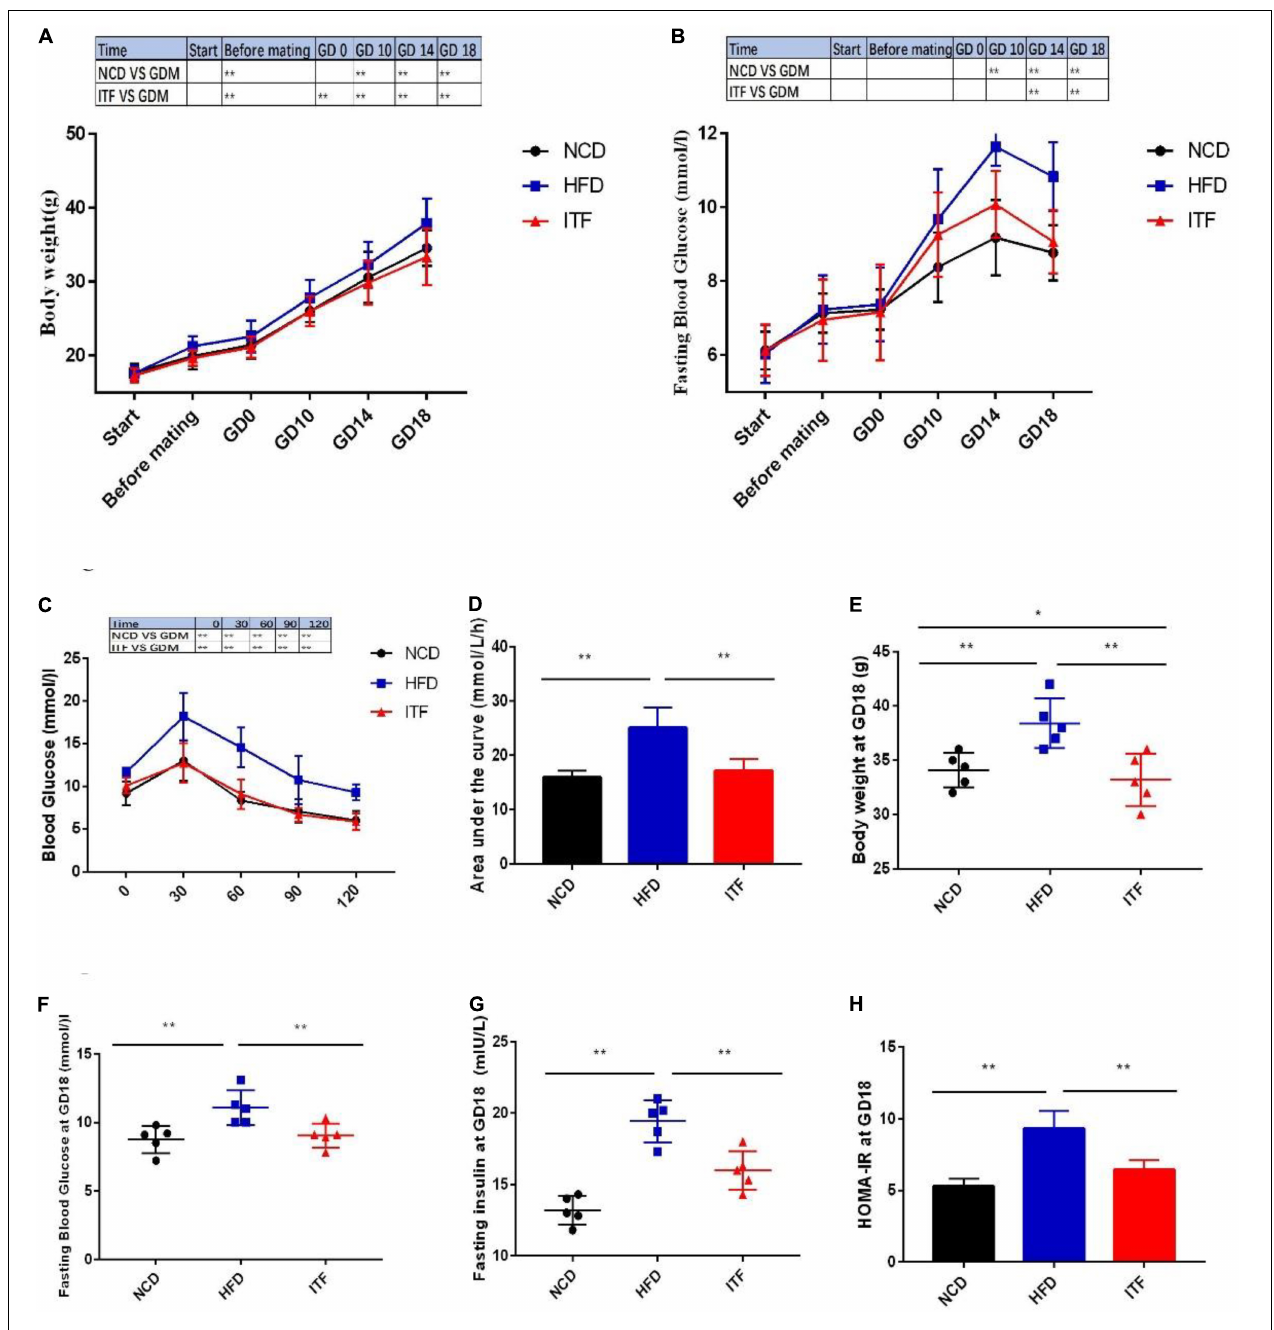
FIGURE 1 | Improvement in metabolic parameters in HFD-induced gestational diabetes mice by ITF. (A) Body weight. (B) FBG. (C) Plasma glucose profile. (D) Mean AUC measured during the OGTT. (E) Body weight at GD18. (F) FBG at GD18. (G) Fasting insulin at GD18. (H) HOMA-IR at GD18. AUC, area under the curve; OGTT, oral glucose tolerance test. Data are presented as mean ± SEM. Data were analyzed using two-way ANOVA followed by the Bonferroni post hoc test for panels (A,B,F) and using one-way ANOVA followed by the Tukey post hoc test for panels (C–E,G) . * p < 0.05, ** p <